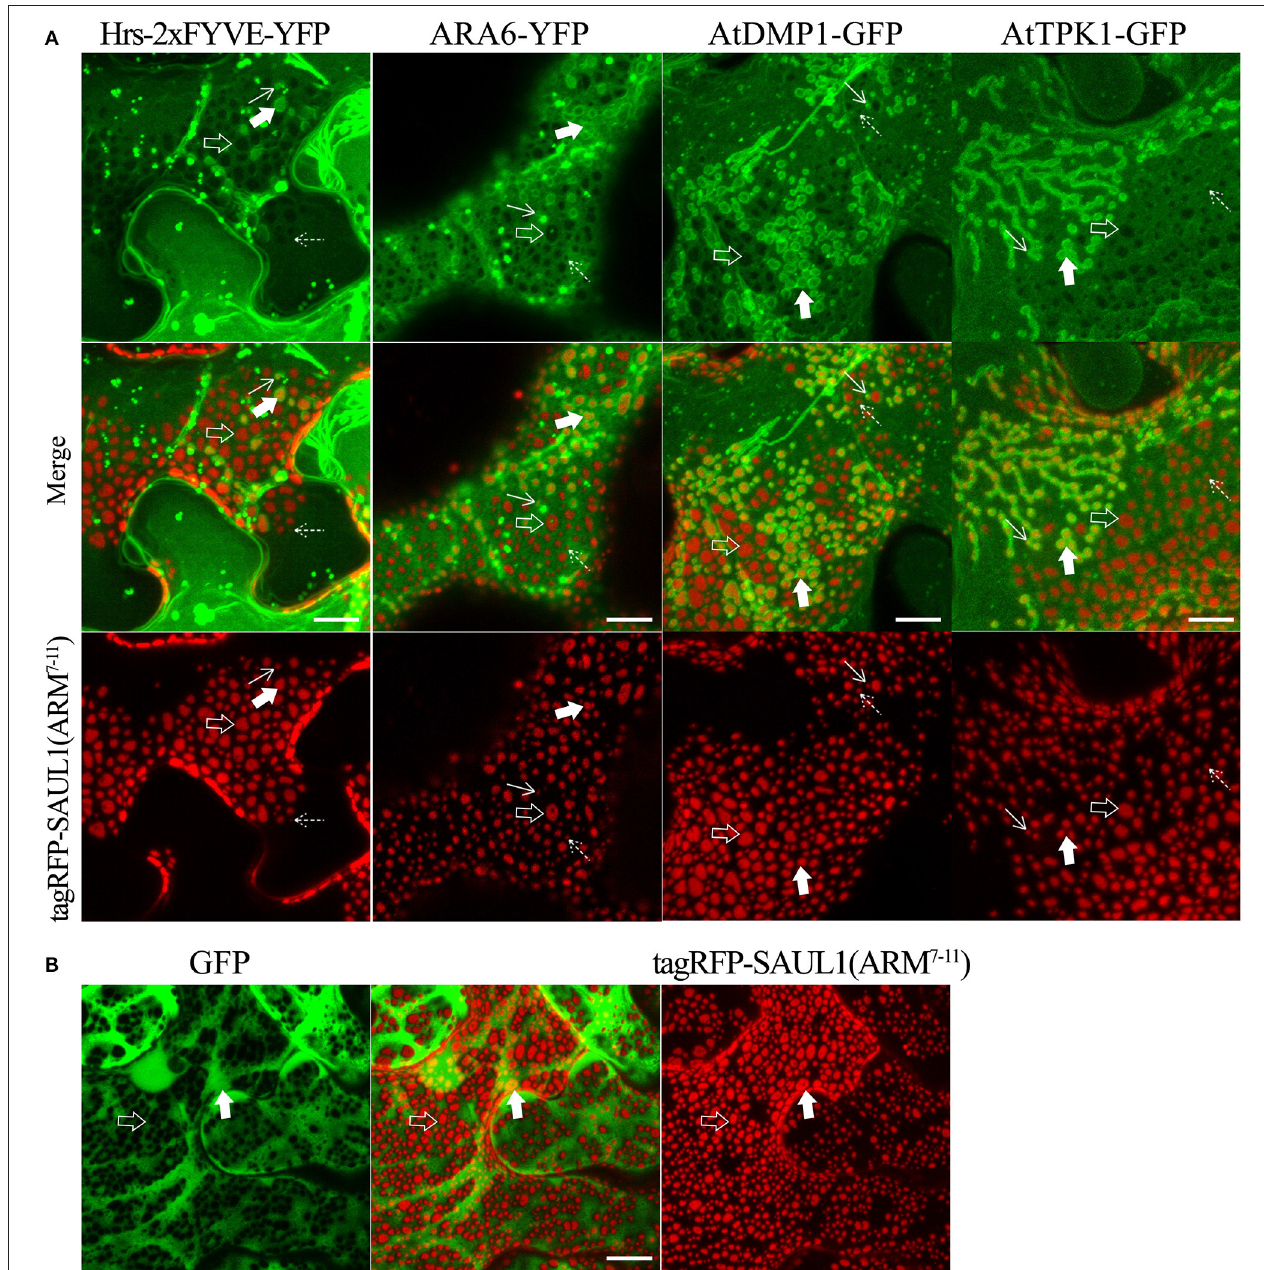
FIGURE 7 | Distribution of fluorescent tonoplast, MVB and cytoplasmic marker proteins in the presence of membrane patches created by expression of tagRFP-SAUL1(ARM 7 − 11 ) in N. benthamiana leaf cortical cells. (A) Distinct tonoplast- and MVB-associated patches revealed by co-expression of YFP- or GFP-fused Hrs-2xFYVE, ARA6, AtDMP1 or AtTPK1 with tagRFP-SAUL1(ARM 7 − 11 ). Examples of tonoplast- and MVB-associated patches are highlighted with open and filled arrows, respectively. Similarly, punctae associating with the tonoplast or MVBs, are highlighted by dotted and solid arrows, respectively. (B) Distribution of cytoplasmic GFP co-expressed with tagRFP-SAUL1(ARM 7 − 11 ). Examples of tonoplast-associated patches from which GFP has been excluded are highlighted with open arrows while MVB-associated patches from which GFP has not been excluded are highlighted with filled arrows. All scale bars are representing 10 µ